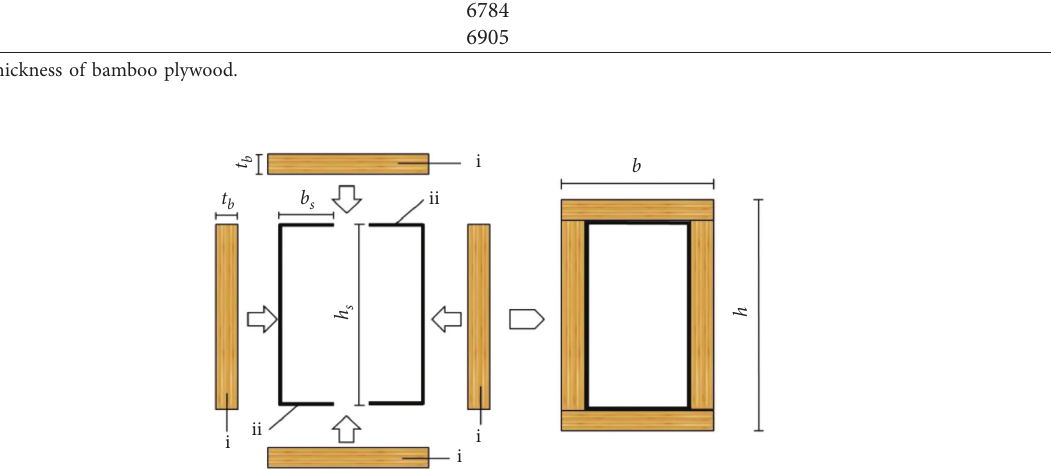
Figure 2: Section form of composite beam: (i) bamboo plywood and (ii) cold-formed thin-walled steel